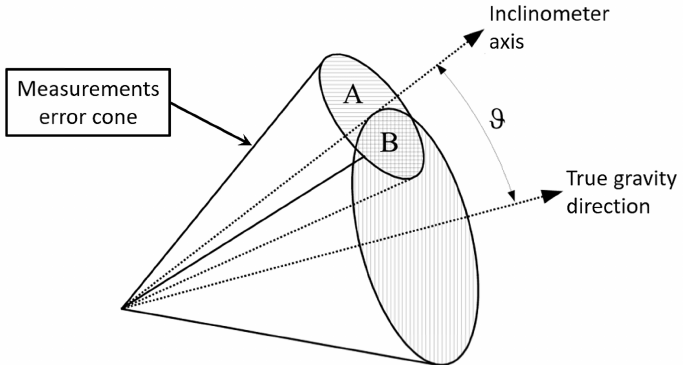
Figure 2. Geometrical explanation justifying the result provided by Equation